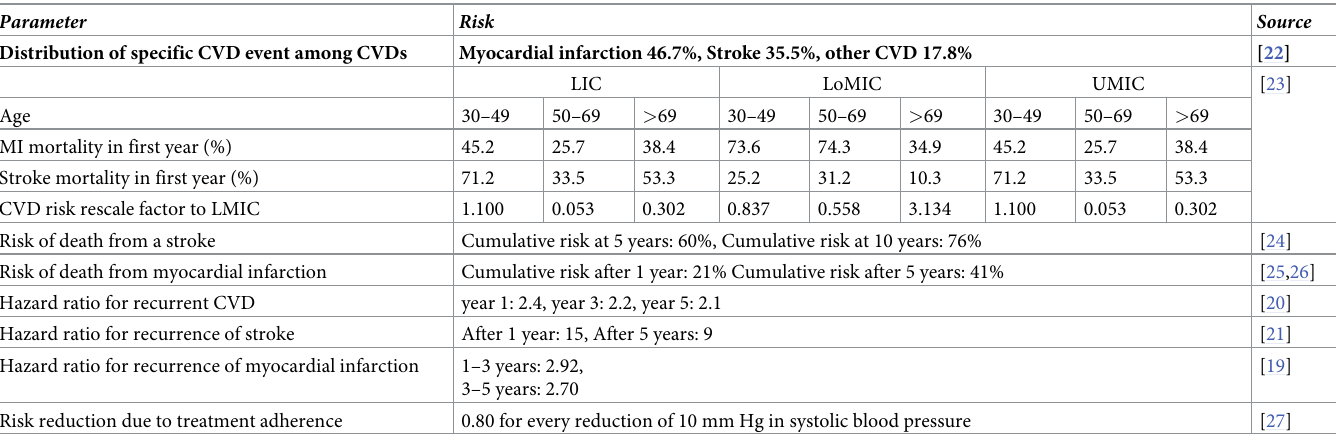
Table 2. Parameters for the distribution of CVD events, their associated risks, and effect size of treatment used in the simulation.